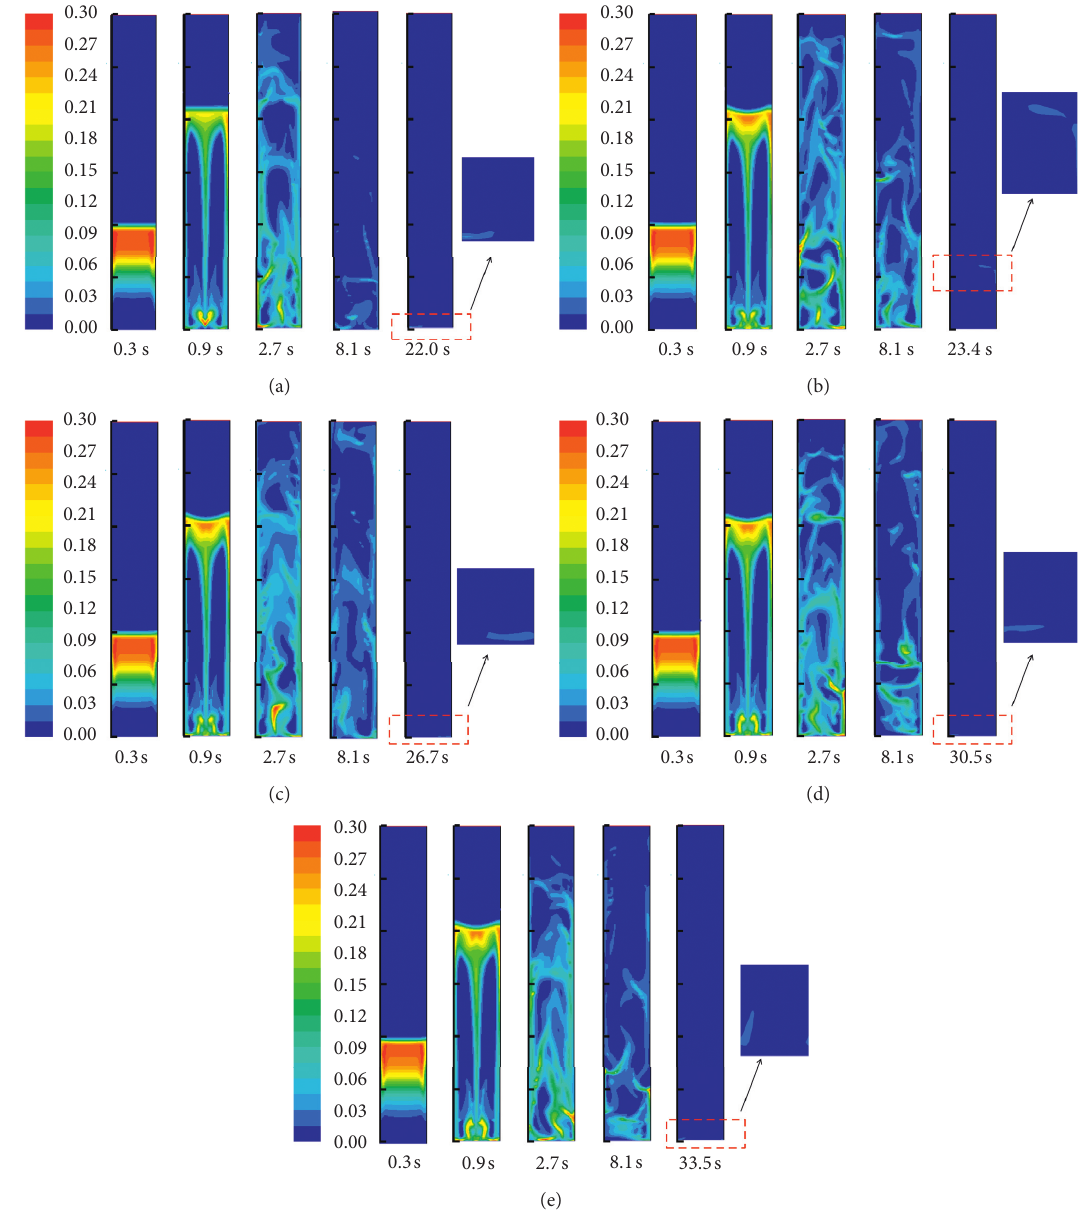
Figure 13: Volume fraction of tar mist: d � 0.20mm and u � 0.70m/s. (a) ρ � 900kg/m 3 . (b) ρ � 950kg/m 3 . (c) ρ � 1000kg/m 3 . (d) ρ � 1050kg/m 3 . (e) ρ � 1100kg/m 3